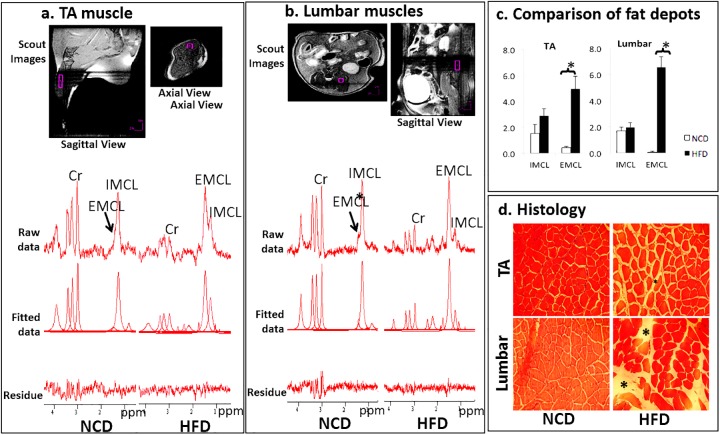
The comparison of tibialis anterior (TA) and lumbar muscles.Representative spectra of TA (a) and lumbar (b) muscles are shown. In both 1a and 1b, scout images (top row) indicate the location of voxels (purple boxes) in both the sagittal and axial view of leg or spinal muscles. Representative spectra (2nd row, raw data) were presented for mice in both normal-control-diet (NCD, left) and high-fat-diet (HFD, right) groups; Raw spectra were analyzed in j-MRUI software to obtain individual fitted component (3rd row, fitted data). The differences between raw data and fitted data in the 4th row (residue); Cr, indicates creatine peak (3.02ppm), and used as reference to measure intramyocellular lipid (IMCL, (1.3ppm) and extramyocellular lipid (EMCL,1.5ppm). (c) The comparison of fat accumulation with and without HFD* Indicates p<0.05. The amount of IMCL/EMCL were recorded as a ratio to Cr-peak, hence it does not associate with an actual unit (y-axis). Representative histology (d) verifies the increases of EMCLs in both TA and lumbar muscles in HFD group. The pale spaces (indicated by “*”) between red stained cell marks the presences of EMCLs, whereas IMCL is not sensitive to the histological staining.